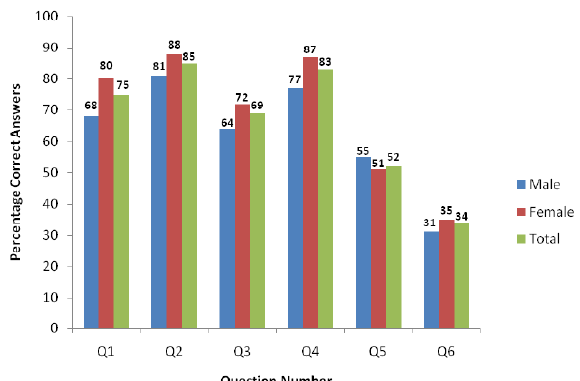
Figure 3: Showing the percentages of respondents within each gender who gave the correct answers. The percentages of the respondents who provided the correct answers among those who responded to each question are shown as total. Females